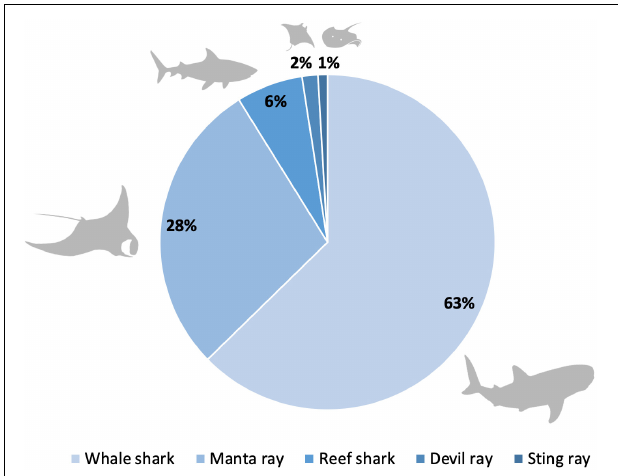
FIGURE 4 | Tourist preferences for which marine animals they would most like to see while diving ( n =